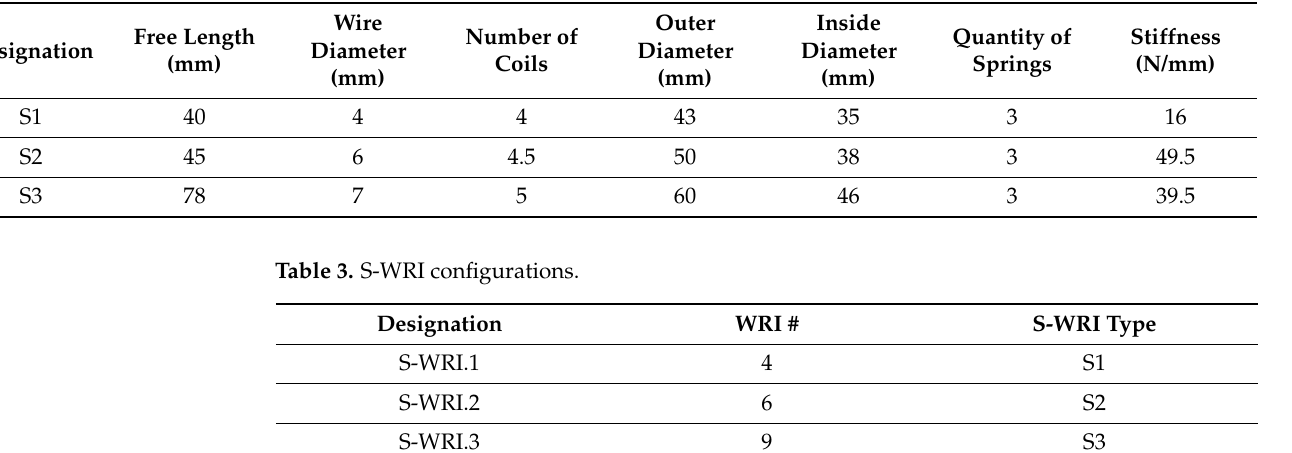
Figure 7. Test setup for S-WRI: ( a ) vertical and ( b ) lateral (roll). Table 4. Performance of S-WRI against WRI in terms of stiffness.